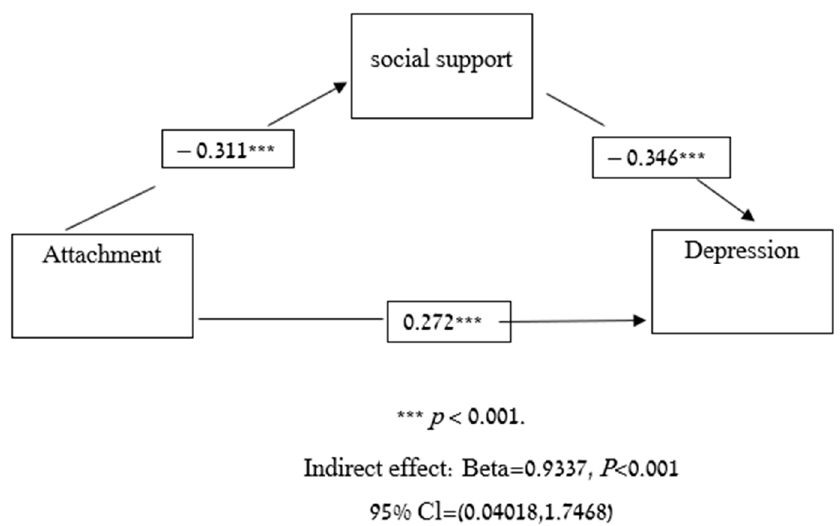
Figure 1. Mediation model-attachment, social support and depression.